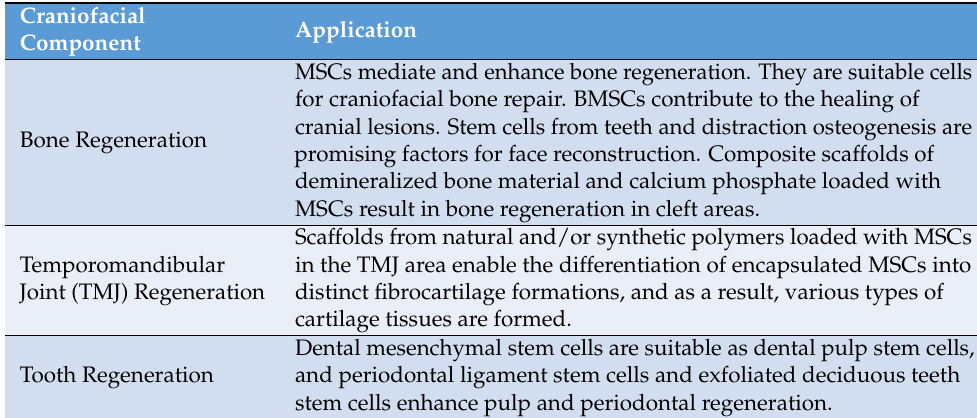
Table 2. Applications of biotechnology for regeneration in the craniofacial